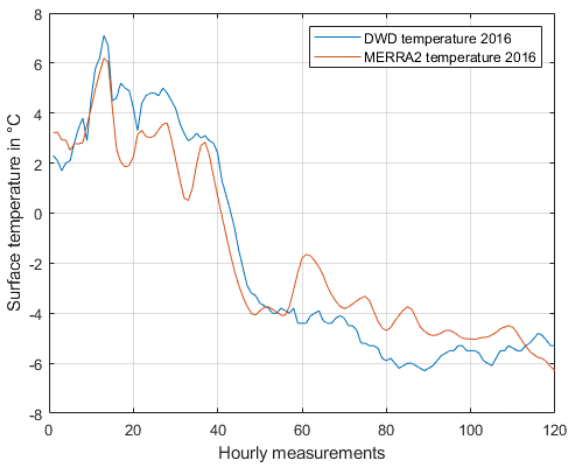
Figure 5. DWD and MERRA-2 surface temperature (TS) for 1 January 2016–5 January 2016 in Bremen. Figures 6 and 7 show the scatter diagrams of global irradiance in Bremen for both datasets in 2016 and 2017.